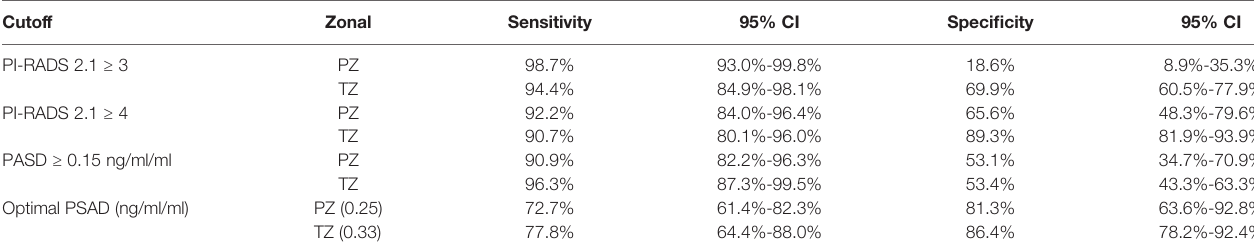
TABLE 2 | Diagnostic accuracy of PI-RADS and PSAD. Cutoff